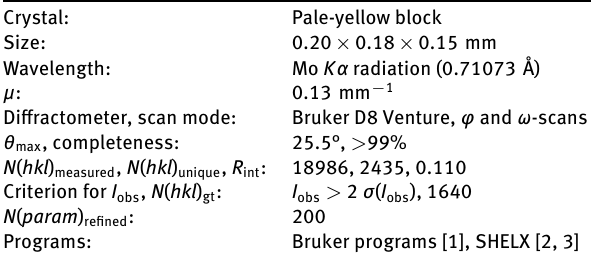
Table 1: Data collection and handling. Crystal: